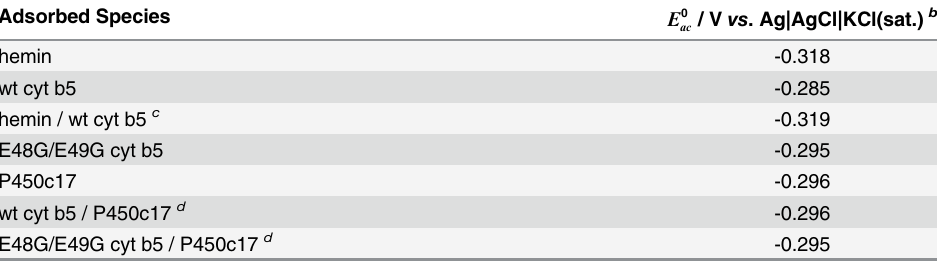
a Average of the potentials of the central minimum in the 6 th a.c. harmonic (envelope presentation, in Fig 3) from the forward and backward d.c. potential sweep directions. b Values are reproducible to ± 0.001 V.